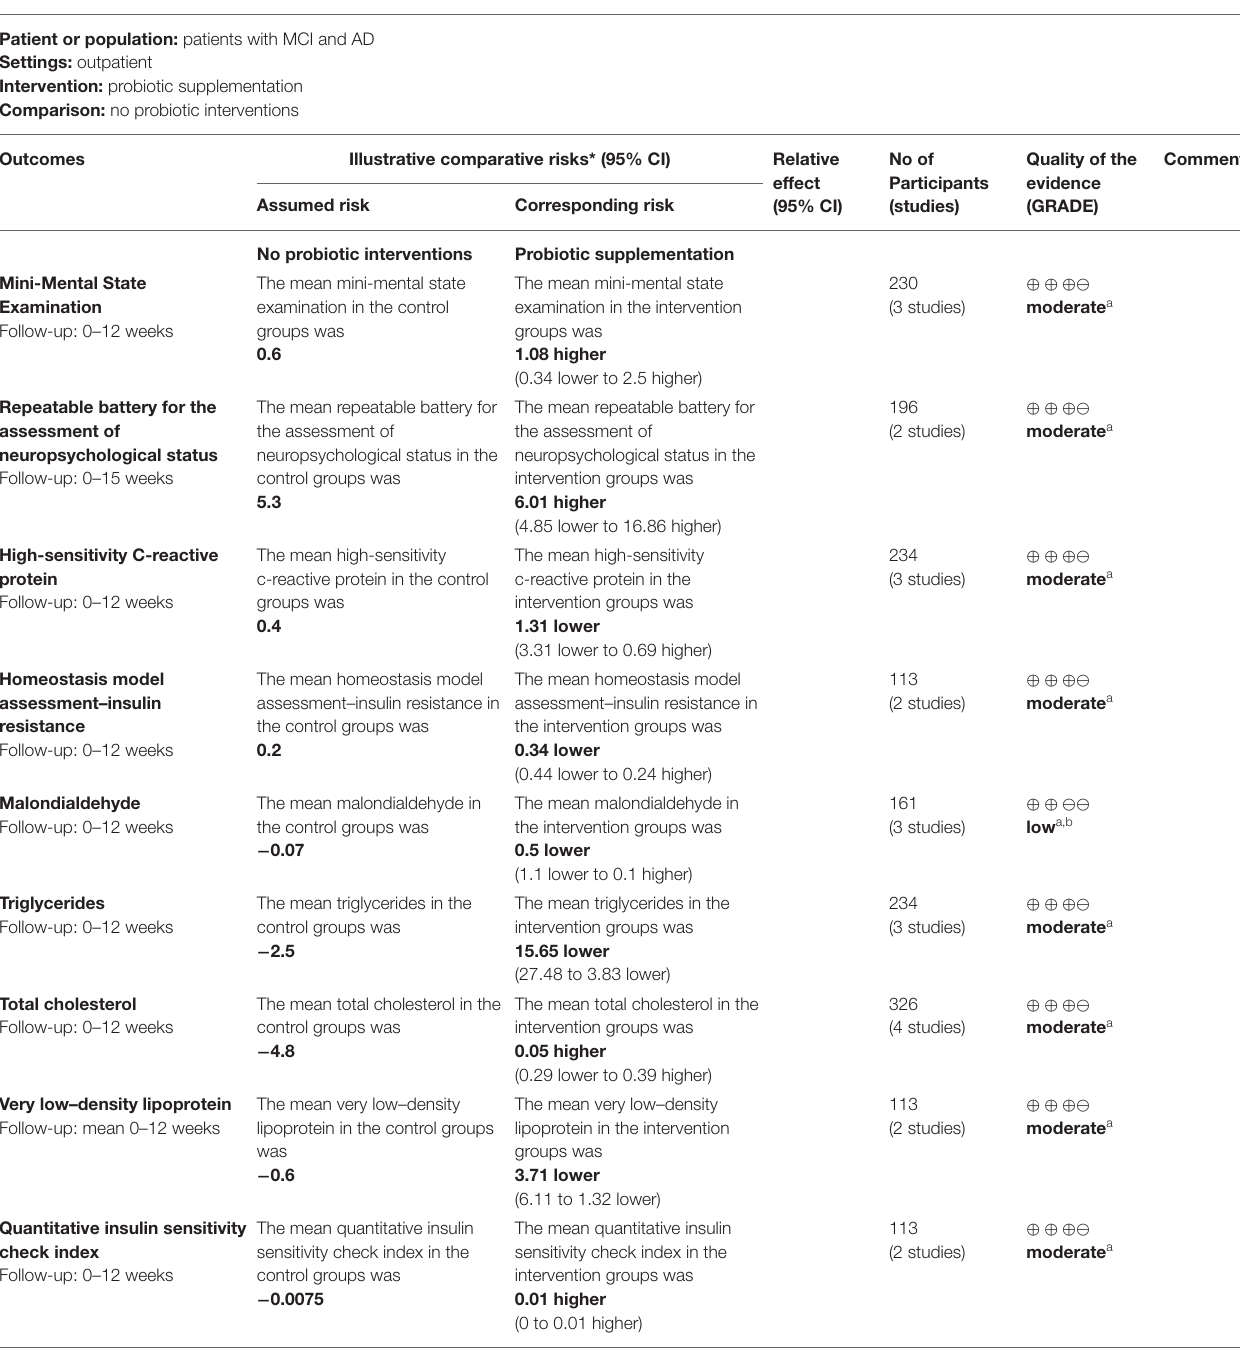
TABLE 2 | Summary of findings table. Effect of probiotic supplementation on cognitive function and metabolic status in MCI and AD Patient or population: patients with MCI and AD Settings: outpatient Intervention: probiotic supplementation Comparison: no probiotic